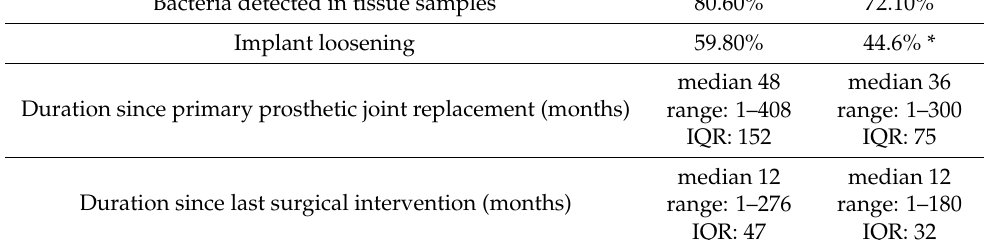
Table 1. Summary of patients ( n = 209) with prosthetic joint infection of the hip and knee included in the study; IQR (interquartile